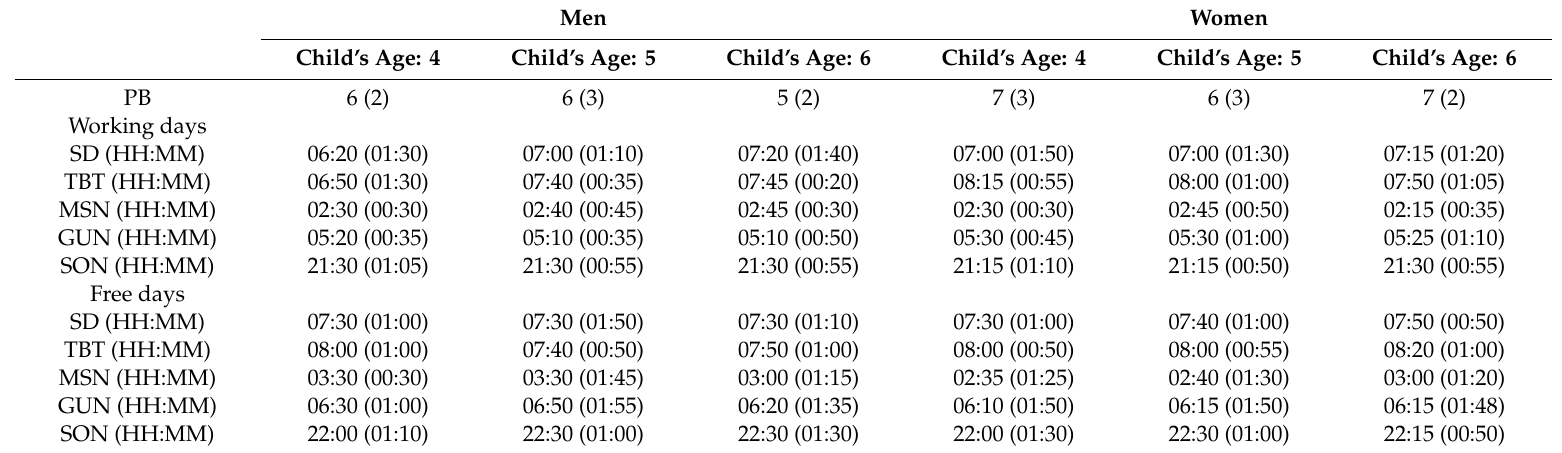
Table 1. Medians and 10th percentile–90th percentile ranges of relationship scores and sleeping features of 221 couples when their children are at specific ages (in years) while participating in the SPATZ